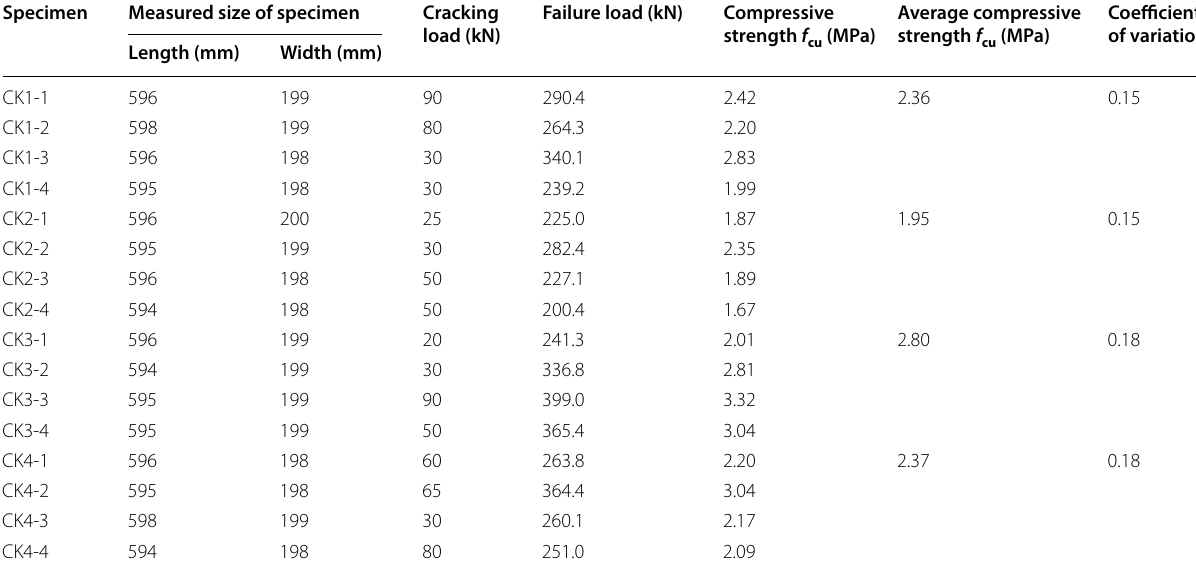
Table 3 Test results of compressive strength of masonry specimens. Specimen